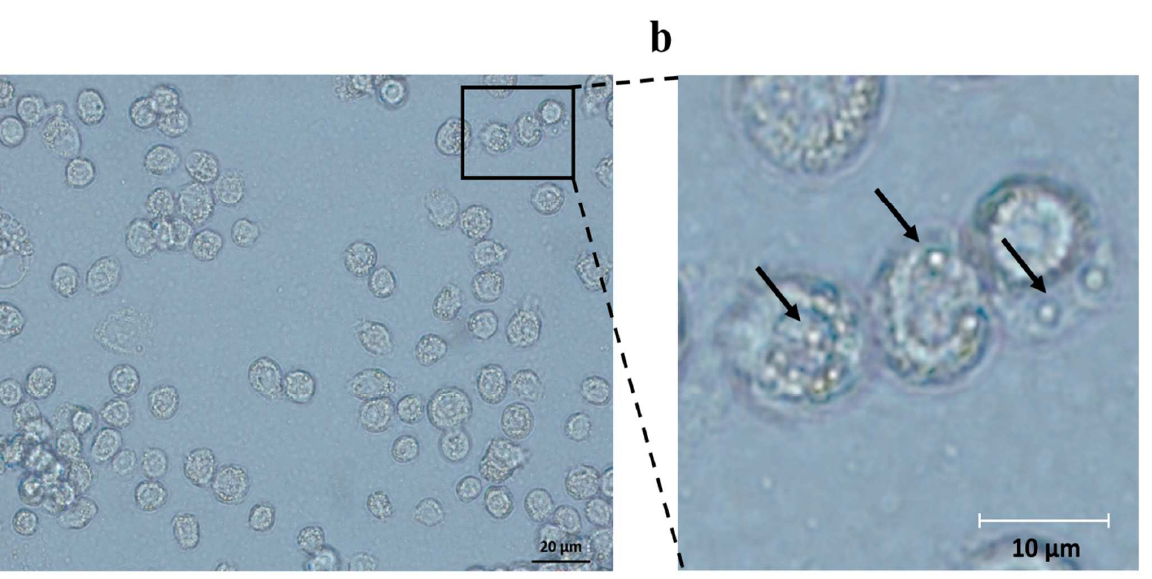
Figure 2. Detection of occlusion body in the BmN cells co-infected with Bm-UPS and Bm-Gal4. Virus-infected cells were visualized by microscopy at 72 h after infection under visible bright light. The scale bars indicate 20 μm ( a ) and 10 μm ( b ) respectively. Some of the inclusion bodies are indicated by arrowheads.